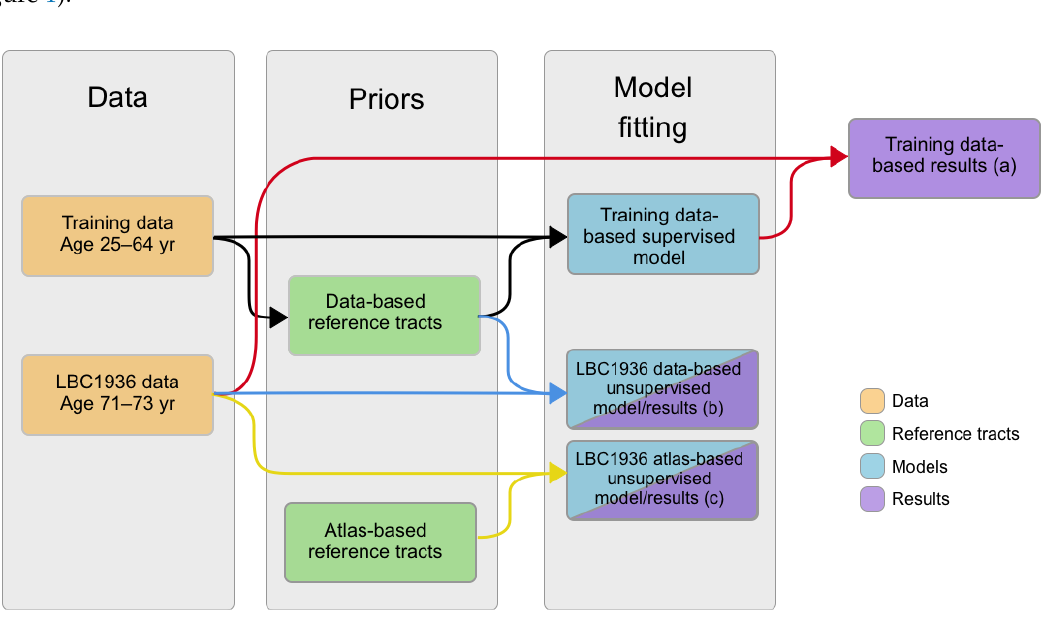
Figure 1. Flow chart of the processes followed in this manuscript. Black paths show the creation of the data-based reference tracts and training data-based supervised models (which represent the deviations of the training data), using the training data. Color paths show the three cases of tract segmentation performed in the LBC1936 data: red paths use the data-based reference tracts and the training data-based models to segment white matter tracts; blue paths use the data-based reference tracts in the LBC1936 data to create models (which represent the deviations of the tracts corresponding to LBC1936 data), and segment the tracts simultaneously using expectation–maximization (EM); and, yellow paths use the atlas-based reference tracts to create models (which represent the deviations of the tracts corresponding to LBC1936 data), and segment the tracts simultaneously using EM.